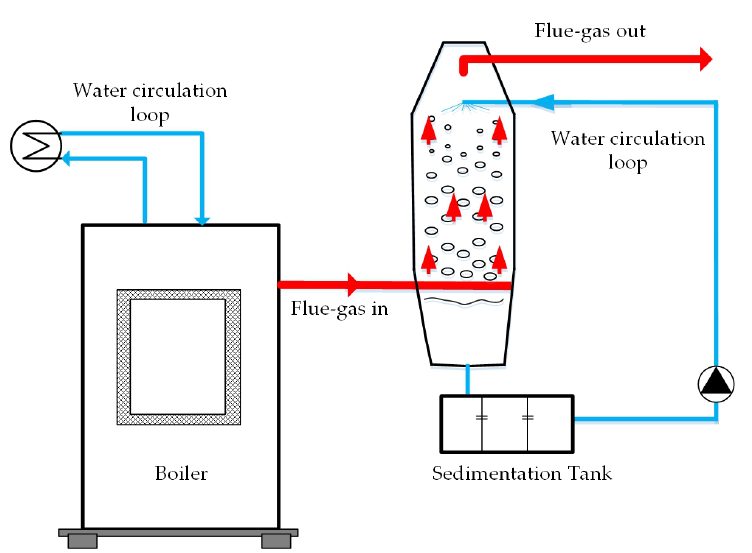
Fig. 3. Schematic of fog unit (without